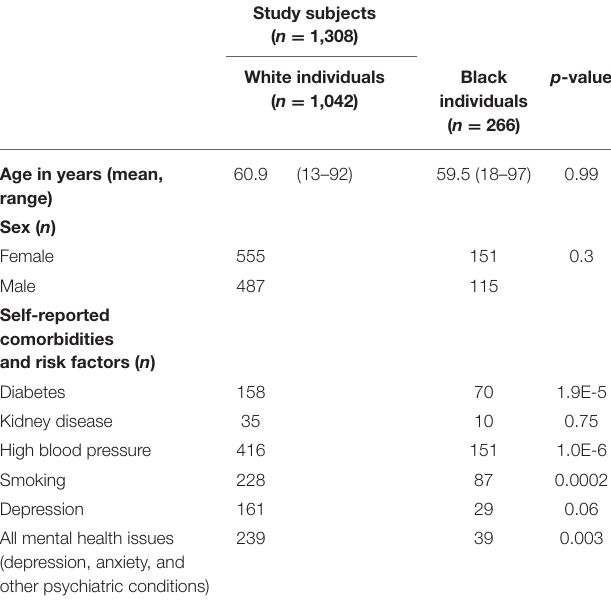
TABLE 1 | Description of study participant demographic characteristics and risk factors associated with oral health outcomes. Study subjects ( n =